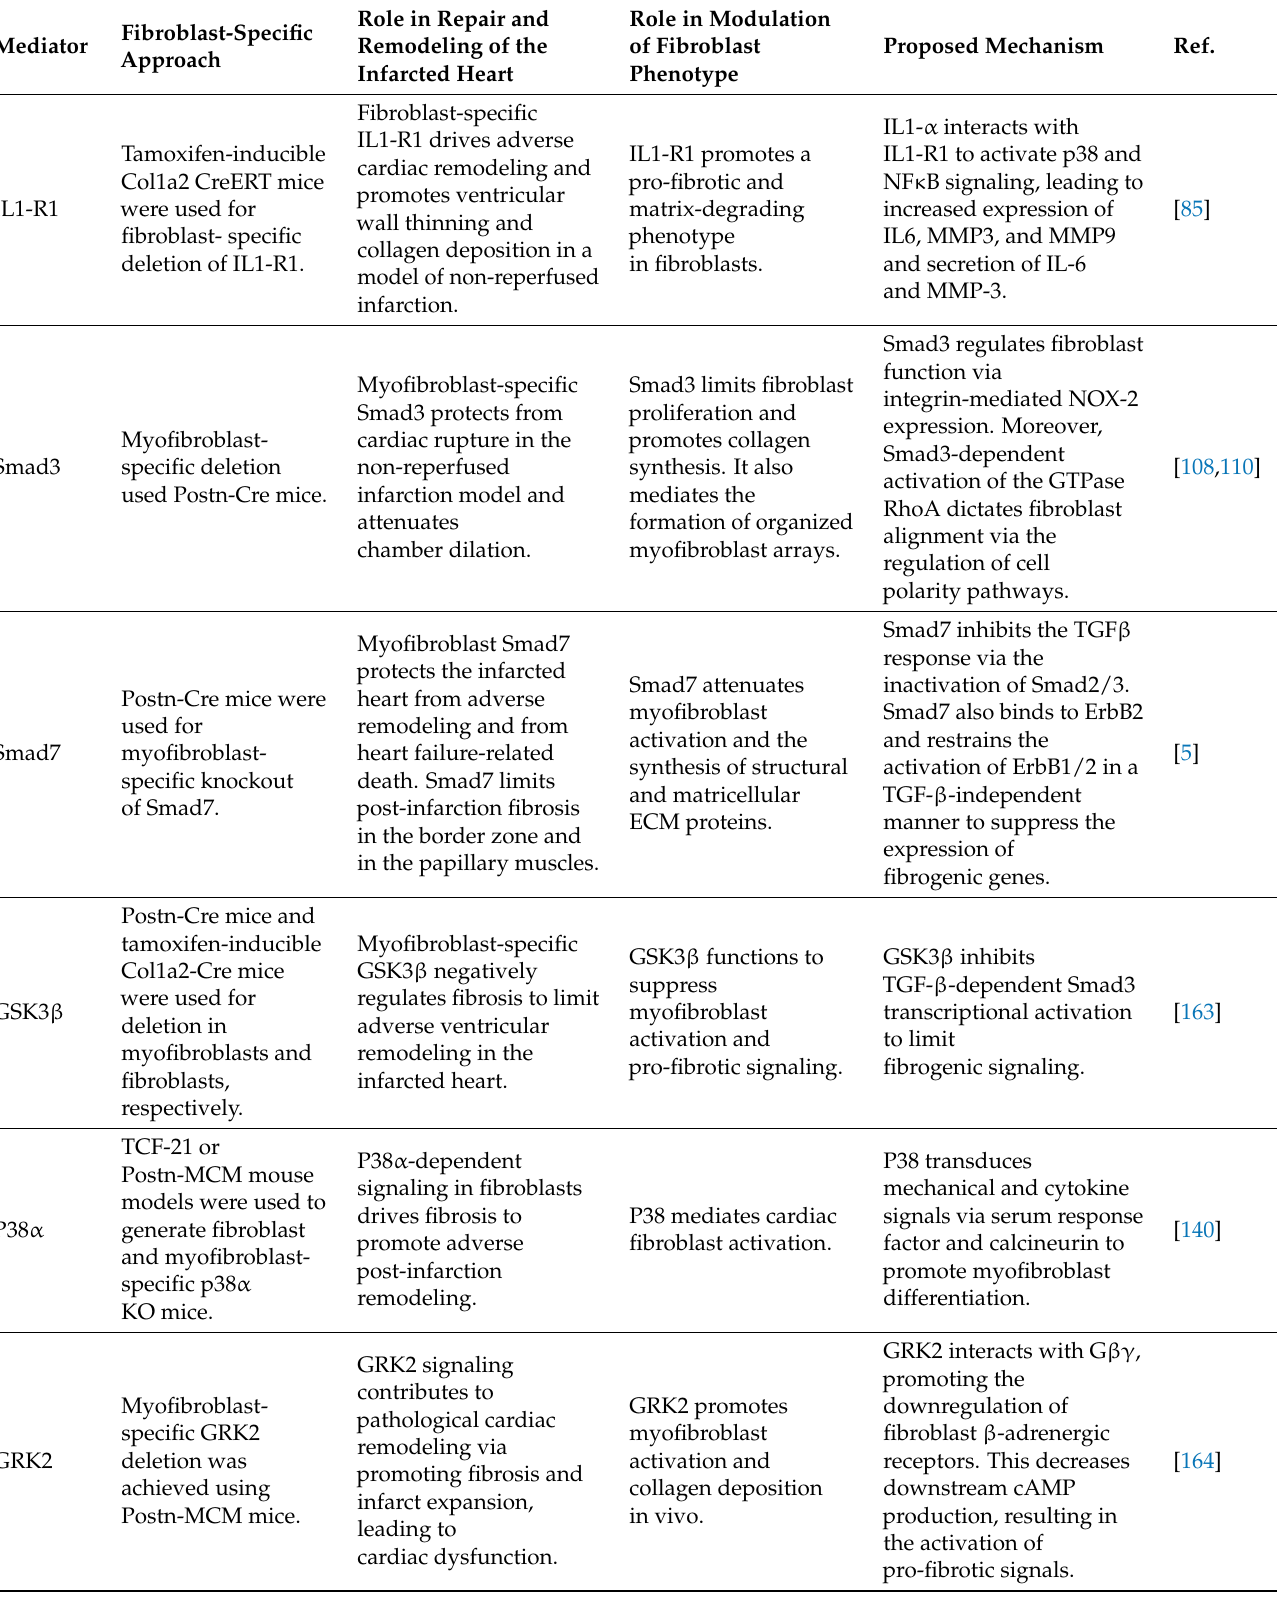
Table 2. Studies documenting fibroblast-mediated signaling in repair and remodeling of the infarcted heart using fibroblast-specific targeting